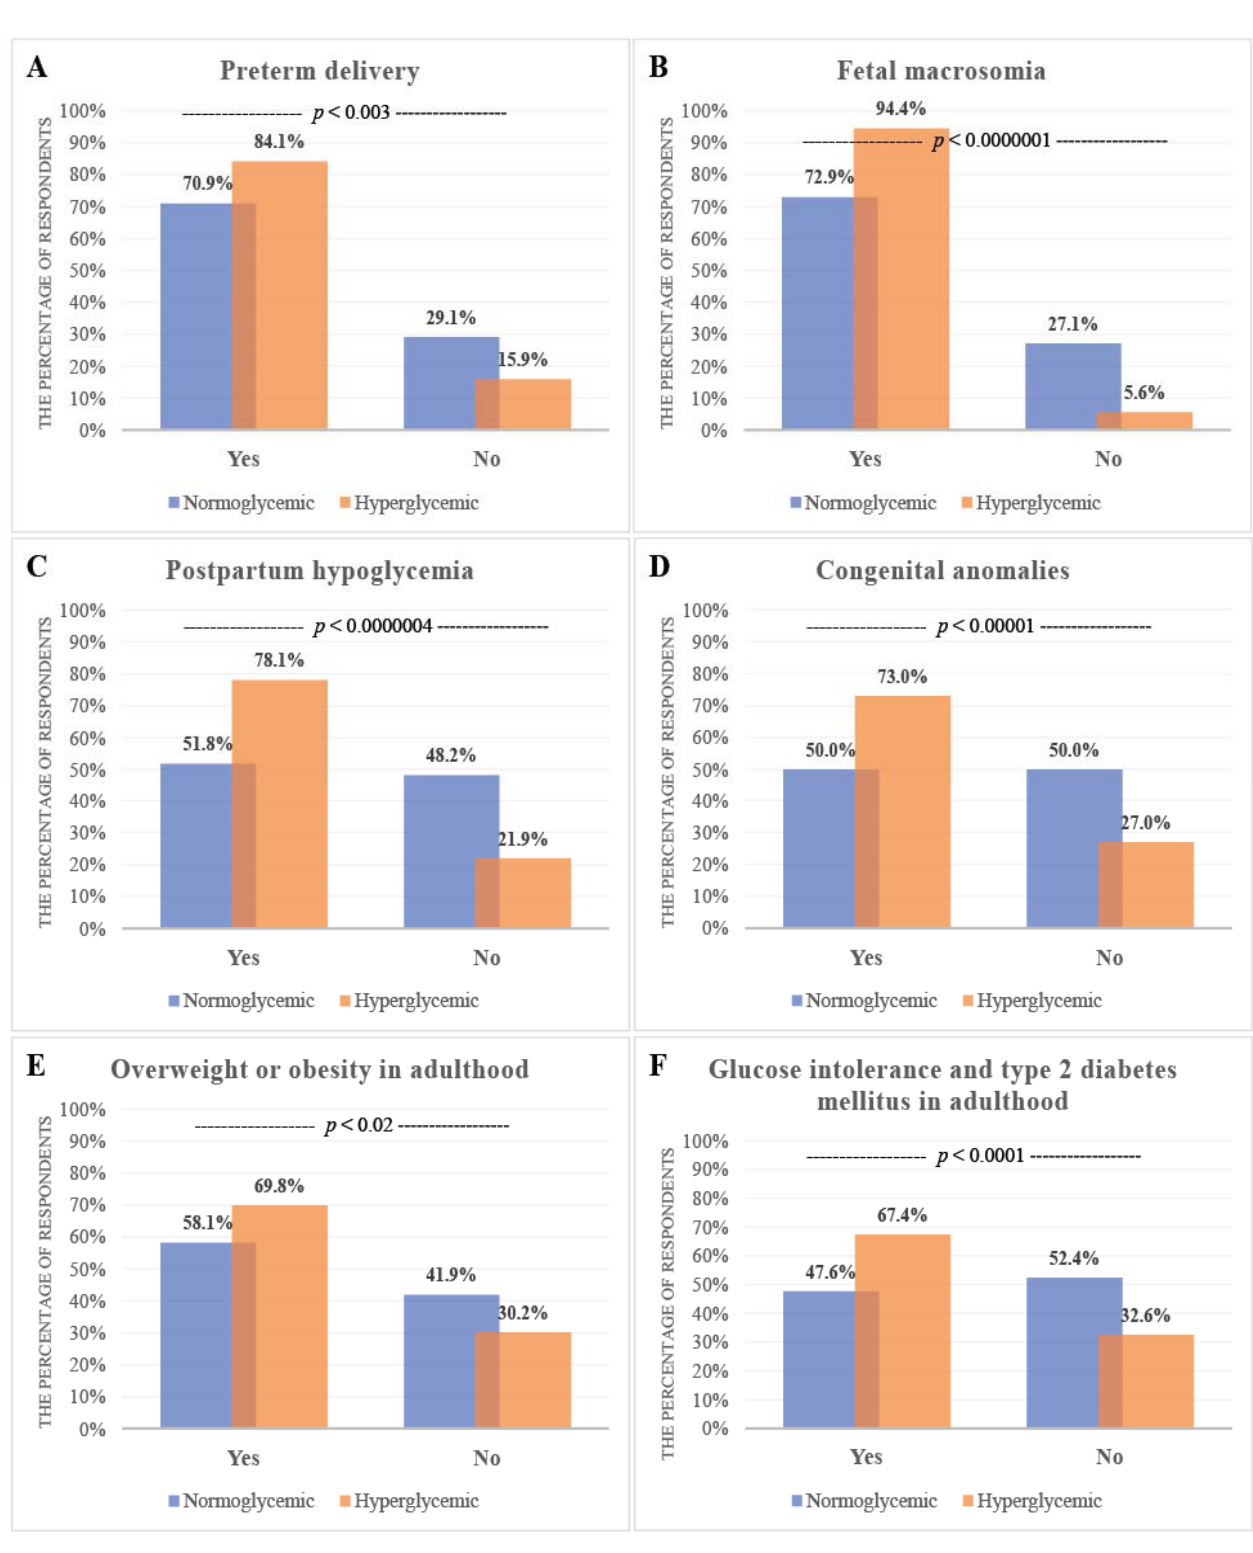
Figure 3. Women’s knowledge concerning adverse neonatal outcomes of GDM and in relation to maternal glycemic status. Knowledge levels among hyperglycemic and normoglycemic mothers. ( A ) Higher risk of preterm delivery, ( B ) Higher risk of fetal macrosomia, ( C ) Higher risk of postpartum hypoglycemia in the newborn, ( D ) Higher risk of having a fetus or neonate affected by congenital anomalies, ( E ) Higher risk of becoming overweight or obese in adulthood, ( F ) Higher risk of developing glucose intolerance and type 2 diabetes mellitus in adulthood. The y axis expresses the percentage of women who said ‘yes’ or ‘no’.